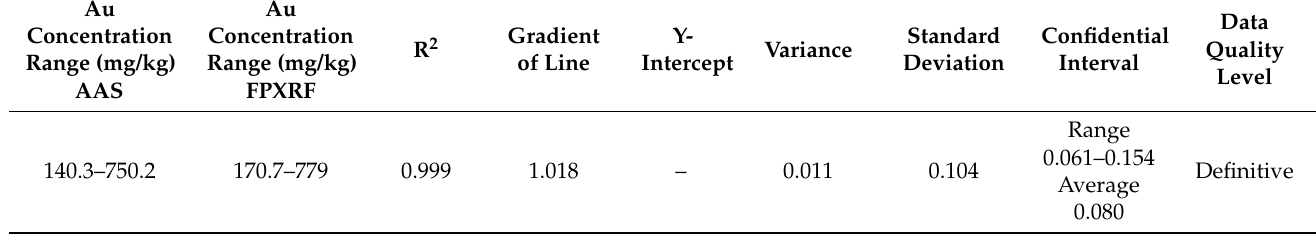
Table 6 and Figure 7 report the results of the statistical analysis. Table 6. Statistical results of the Au concentration.